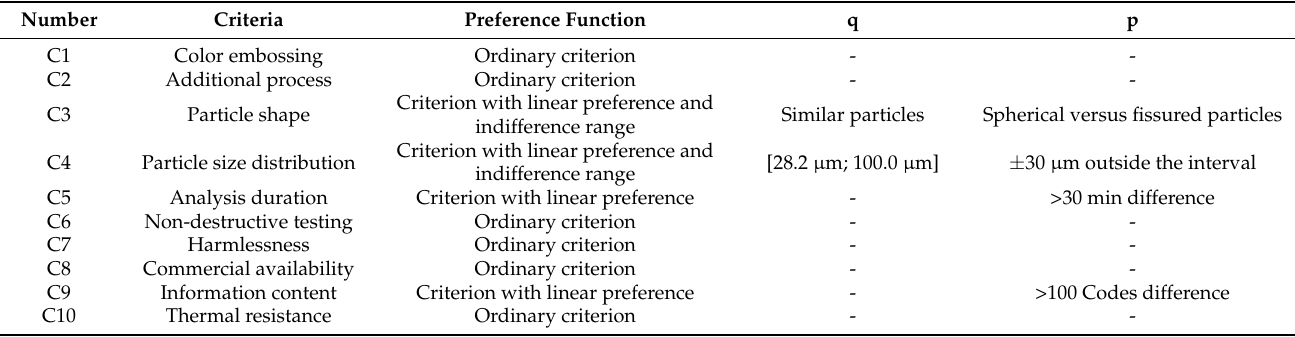
Table 5. Assignment of the used preference